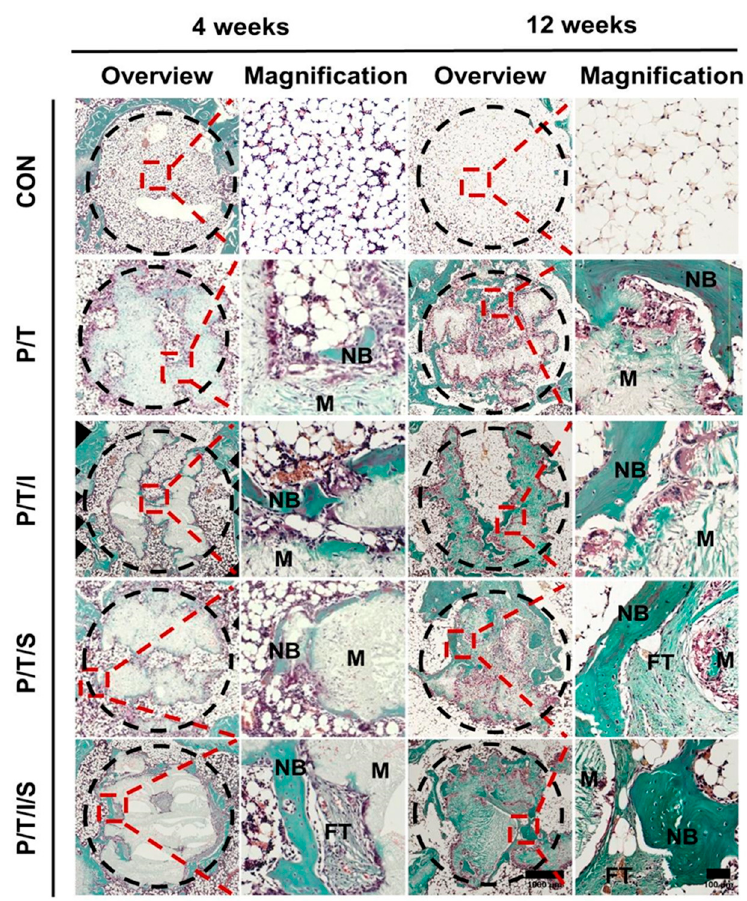
Figure 5. Representative histological images of femoral bone defect at 4 or 12 weeks. Samples were stained by Goldner’s trichrome. The black dashed circle indicates the defect site, and the red dash rectangle indicates the magnified area. NB: new bone, FT: fibrous tissue, M: scaffold materials. For overview images, the scale bar is 1000 µm, while for magnification images it is 100 µm.